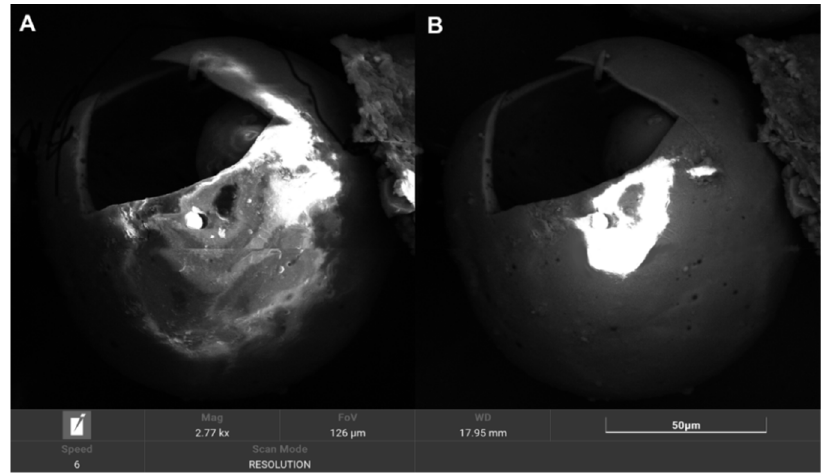
Figure 4. SEM microphotographs of the CS fraction F_212 (energy: 20 keV): ( A ) SE mode, ( B ) BSE mode.